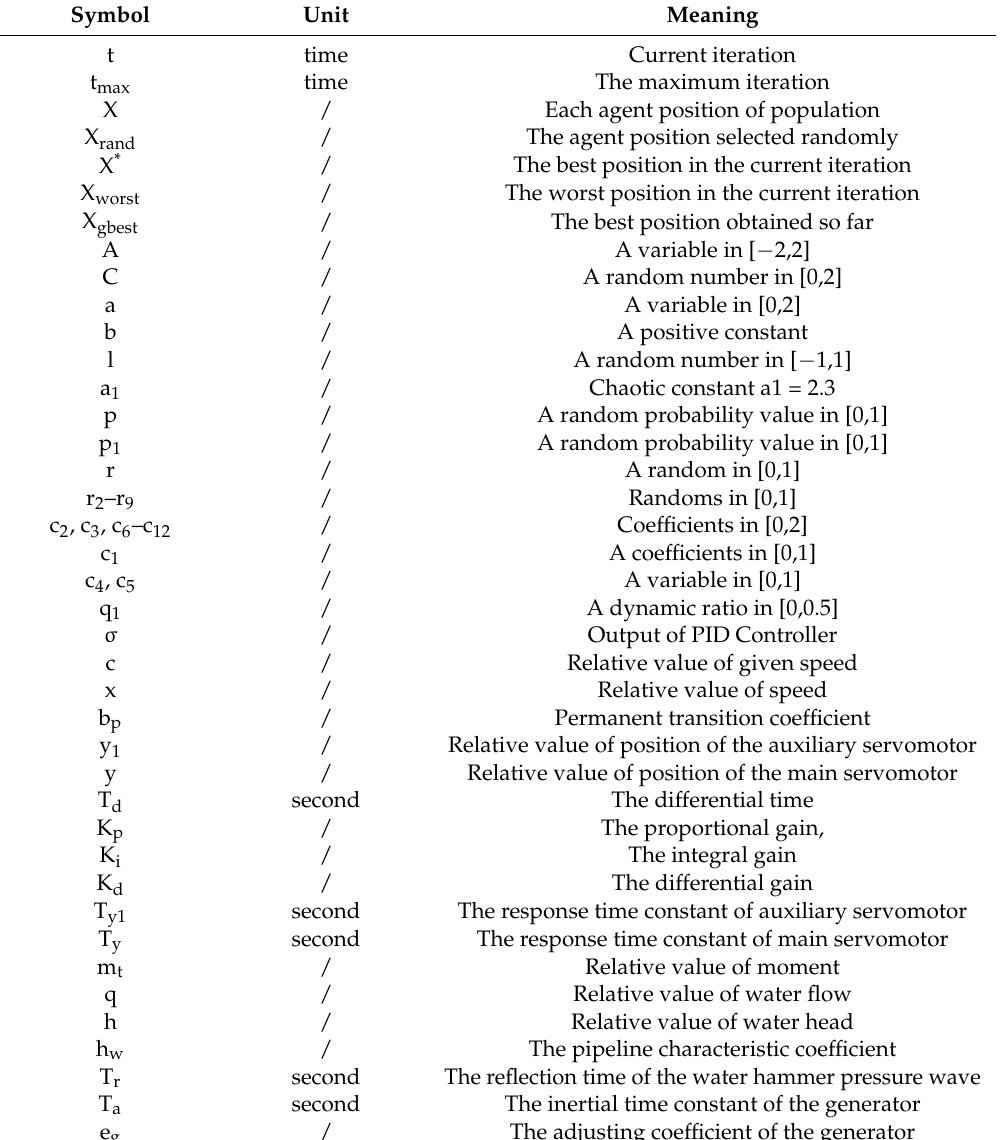
Table 1. The meaning of symbols proposed in this